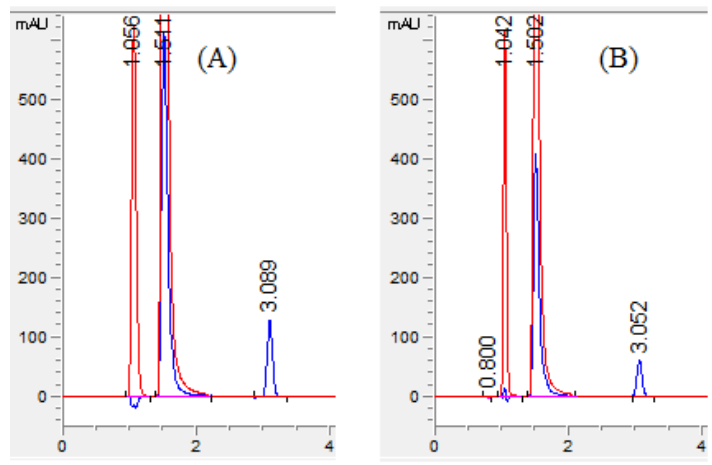
Figure 4. Chromatogram of ( A ) standard solution and ( B ) sample solution. Chromatogram with red color is recorded with 295 nm for MET (1.0 min) and OFL (1.5 min) and blue color is with 231 nm for RAC (3.0 min).